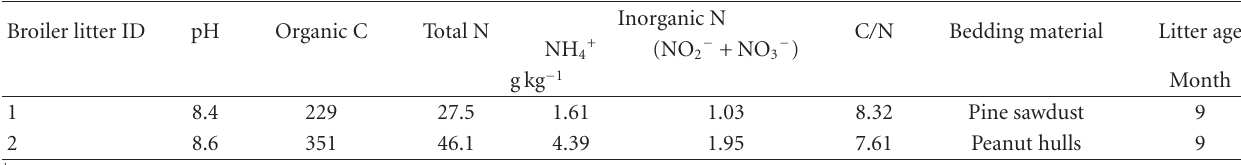
Table 2: Selected properties of the broiler litter used †